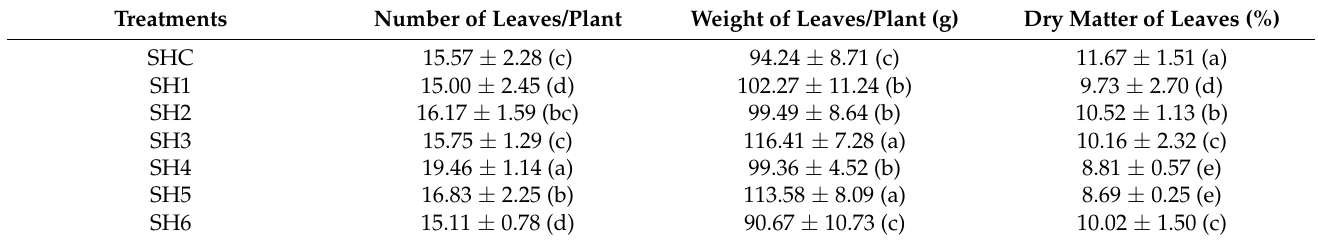
Table 1. The effect of the type of substrate on the weight of plant (g), the weight of leaves/plant (g), the number of leaves/plant and the dry matter of leaves (%) of S. hispanicus plants.